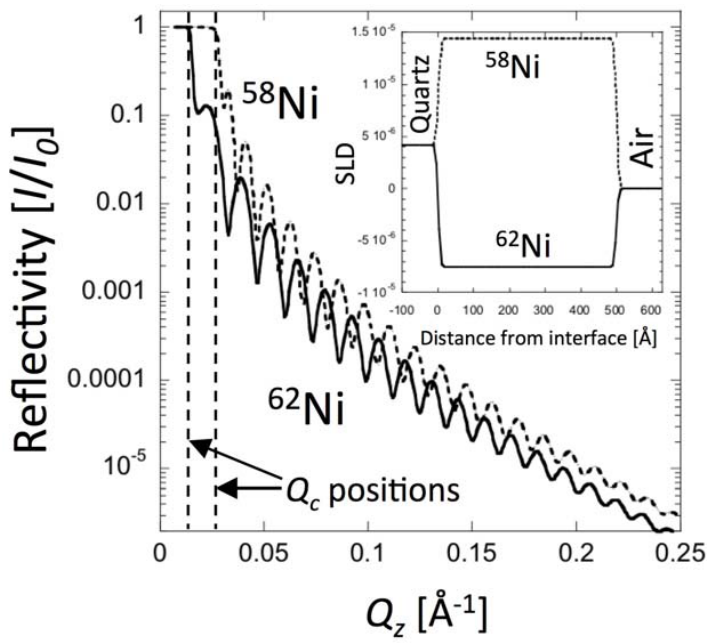
Figure 2. Calculated neutron reflectivity curves for 500 Å films of 58 Ni (dashed line) and 62 Ni (solid line) on a quartz substrate. The inset shows the SLD distributions for each isotope. The simulation was performed using MOTOFIT assuming RMS roughness parameters of 5 Å and the experimental resolution Δ Q z / Q z = 3%.